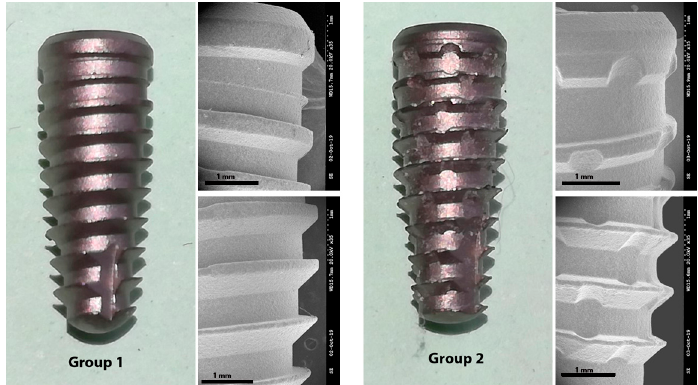
Figure 1. Representative image of the implants tested in each group. SEM images with magnification of x35.